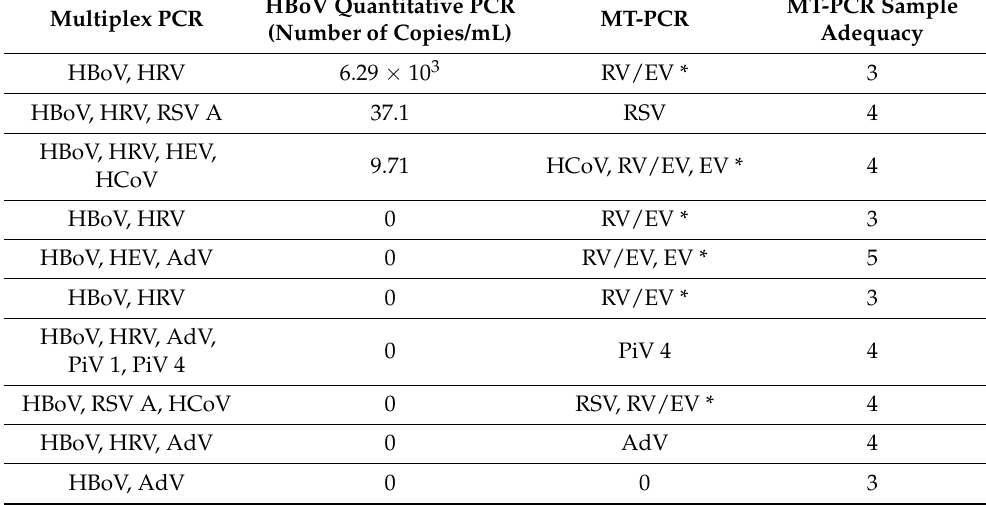
Table 2. Comparison of results between three methods for samples negative for HBoV on MT-PCR ( N =